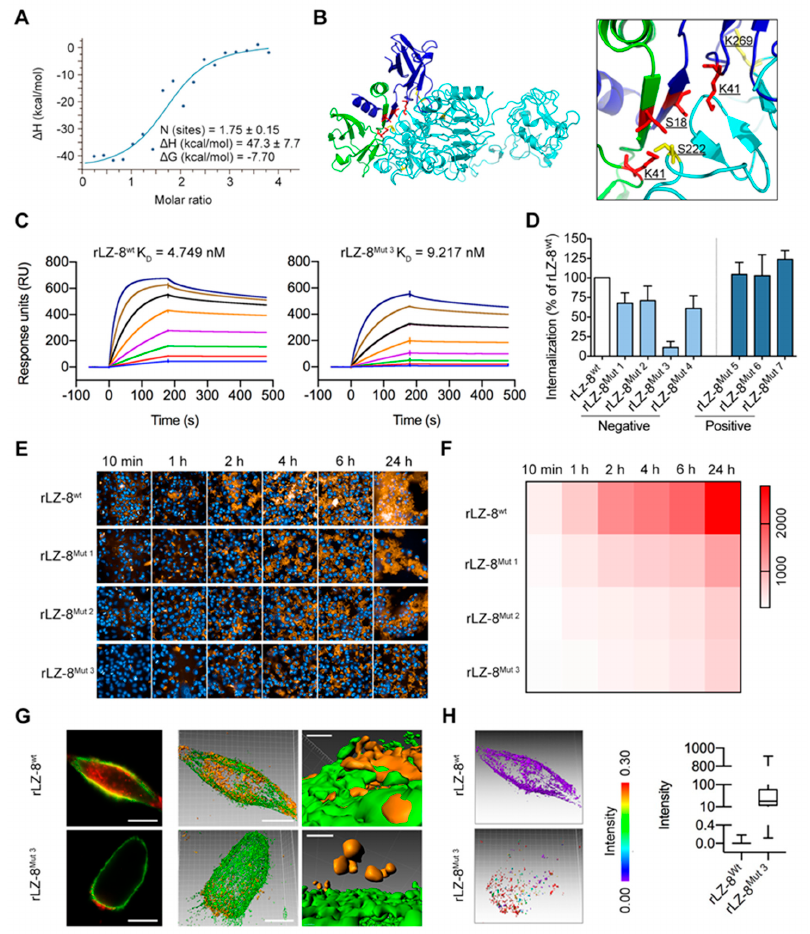
Figure 6. rLZ-8 strongly bound with EGFR via the key residue K41. ( A ) ITC experiments employing purified EGFR ectodomain and rLZ-8. The molar ratio was shown in panel. ( B ) Ribbon representation of identified interface of rLZ-8/EGFR complex, based on the results of chemical Cross-Linking Coupled with Mass Spectrometry (CXMS) and molecular docking. ( C ) Biacore analysis. Recombinant human EGFR was immobilized onto sensor chips and rLZ-8 wt or rLZ-8 Mut 3 were injected at concentrations ranging from 4 nM to 512 nM. K D values were shown on panels. ( D ) Hep3B cells were treated with 10 μ g/mL rLZ-8 wt or rLZ-8 Mut 1-7 for 1 h before cells imaging. The internalization of rLZ-8 Mut 1-7 was analyzed by Imaris. ( E,F ) rLZ-8 wt or rLZ-8 Mut 1-3 (red) treated on Hep3B cells for different times and the cells were imaged by high content imaging system. Cell nuclei were counterstained with Hoechst (blue). Magnification ×60. The internalization of rLZ-8 wt or rLZ-8 Mut 1-3 was analyzed by Harmony software and the thermal figure was shown in ( F ). ( G ) Hep3B cells were treated with 10 μ g/mL rLZ-8 wt or rLZ-8 Mut 3 (red) for 20 min, with EGFR (green) coloring by immunofluorescence (no permeabilized). Surface rendering was generated using Imaris. Scale bars in left 2 columns, 10 μ m; bars in right 1 columns, 2 μ m. ( H ) Distance from rLZ-8 wt /rLZ-8 Mut 3 to the nearest EGFR was measured by Imaris. Varying distances modify fluorescence intensity. All data are means ± SD.